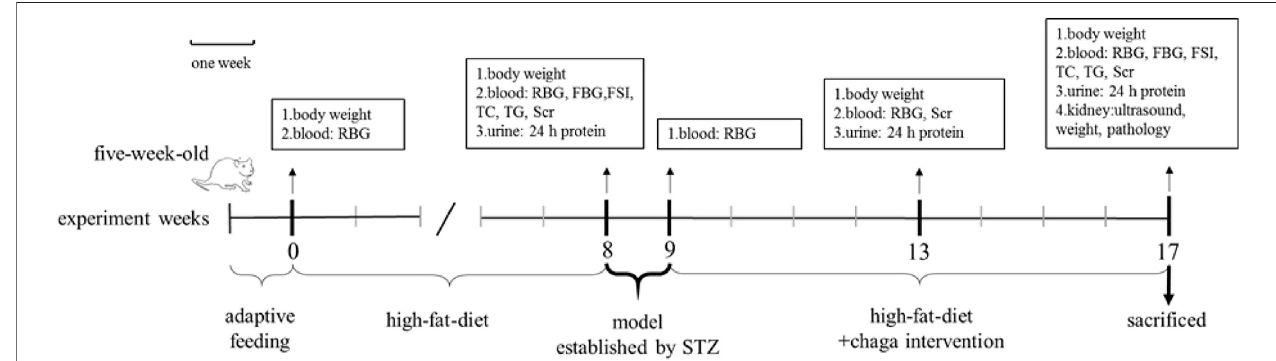
FIGURE 2 | Intervention of chaga extracts on high-fat diet/STZ-induced DKD rats. RBG, random blood glucose; FBG, fasting blood glucose; FSI, fasting serum insulin; TC, total cholesterol; TG, triglyceride; SCr, serum creatinine; STZ, streptozotocin; DKD, diabetic kidney